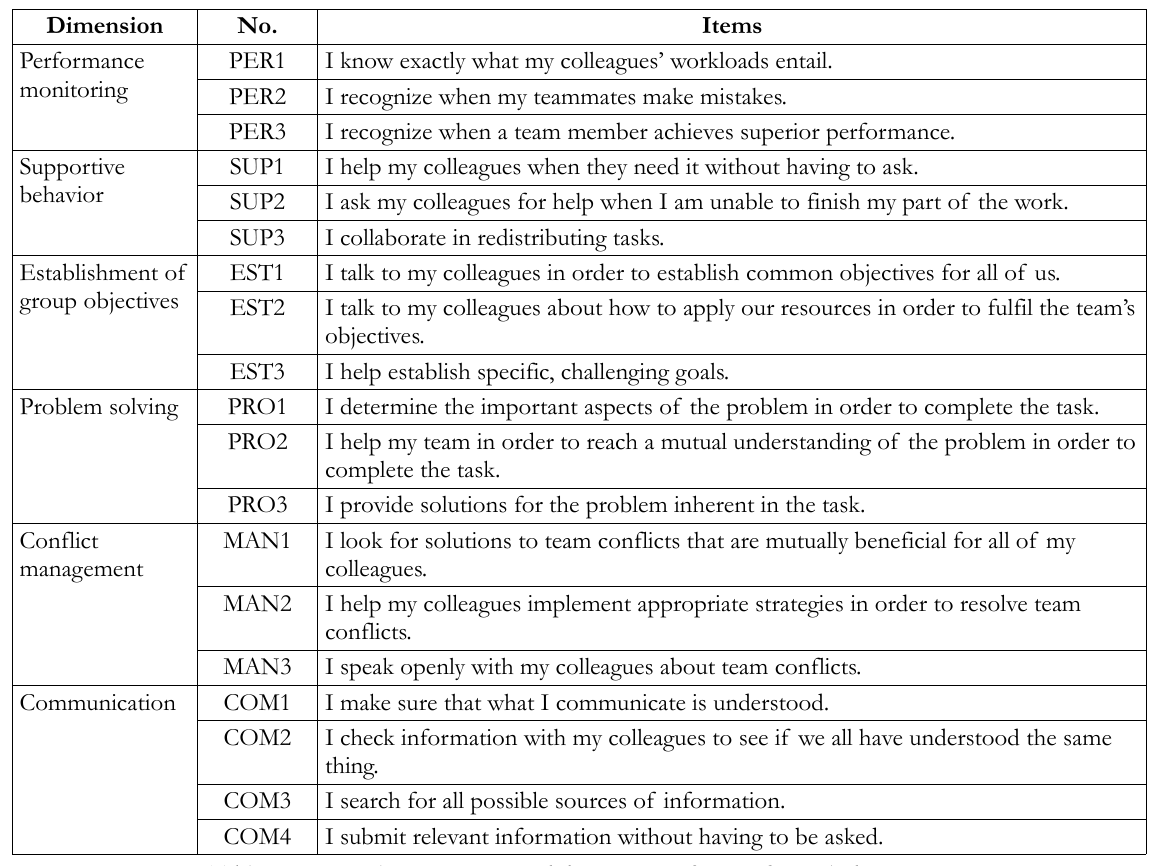
Table 1. Nomenclature (NOM) and description of items for each